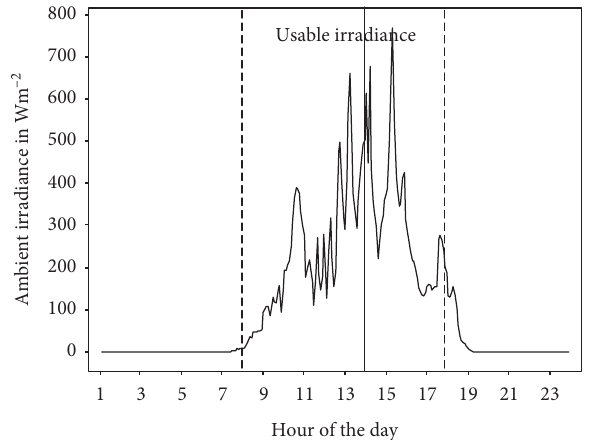
Figure 28: Variation of ambient node irradiance at the